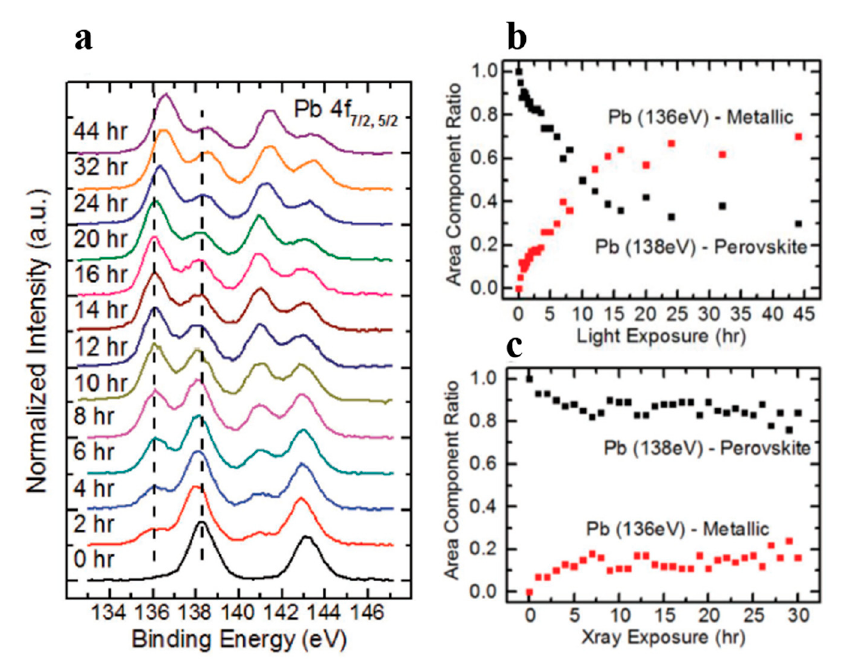
Figure 11. ( a ) A stack plot of the Pb 4f 7/2 and 4f 5/2 core levels of cleaved MAPbBr 3 single crystal with increasing light exposure. ( b , c ) The ratio of perovskite Pb to metallic Pb under light exposure and X-ray exposure, respectively. From Ref. [62] with permission.